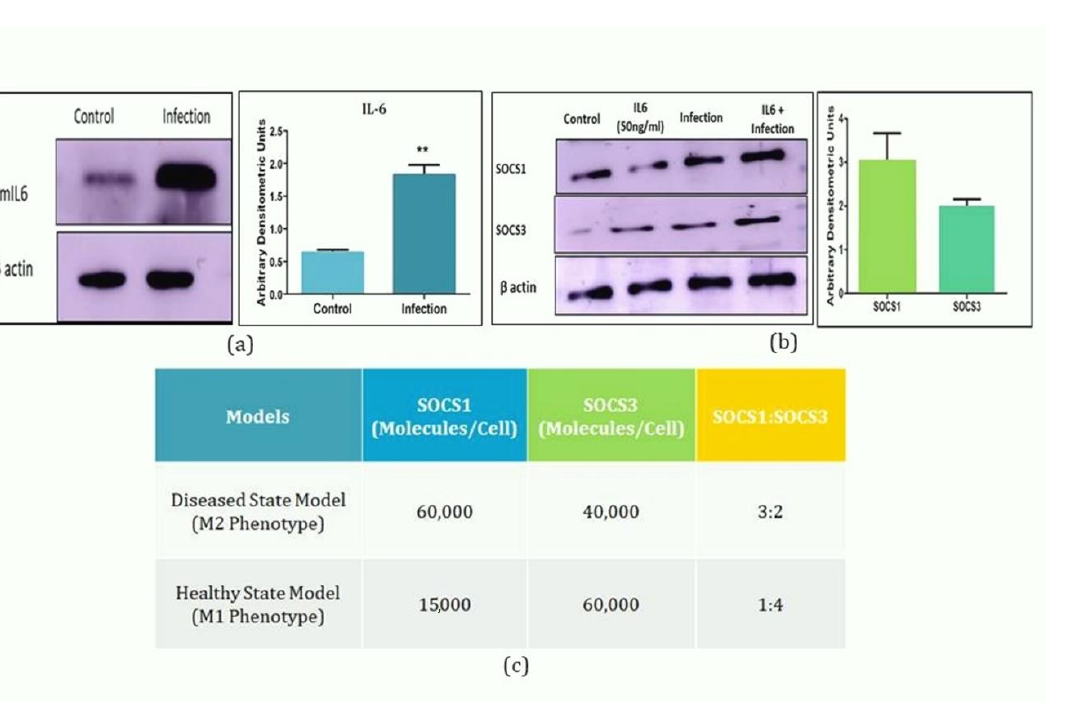
4 of 23 Figure 1. Graphical representation of Systems and Synthetic immunology. 2. Results 2.1. SOCS1/SOCS3 Differential Expression Governing Macrophage Polarization